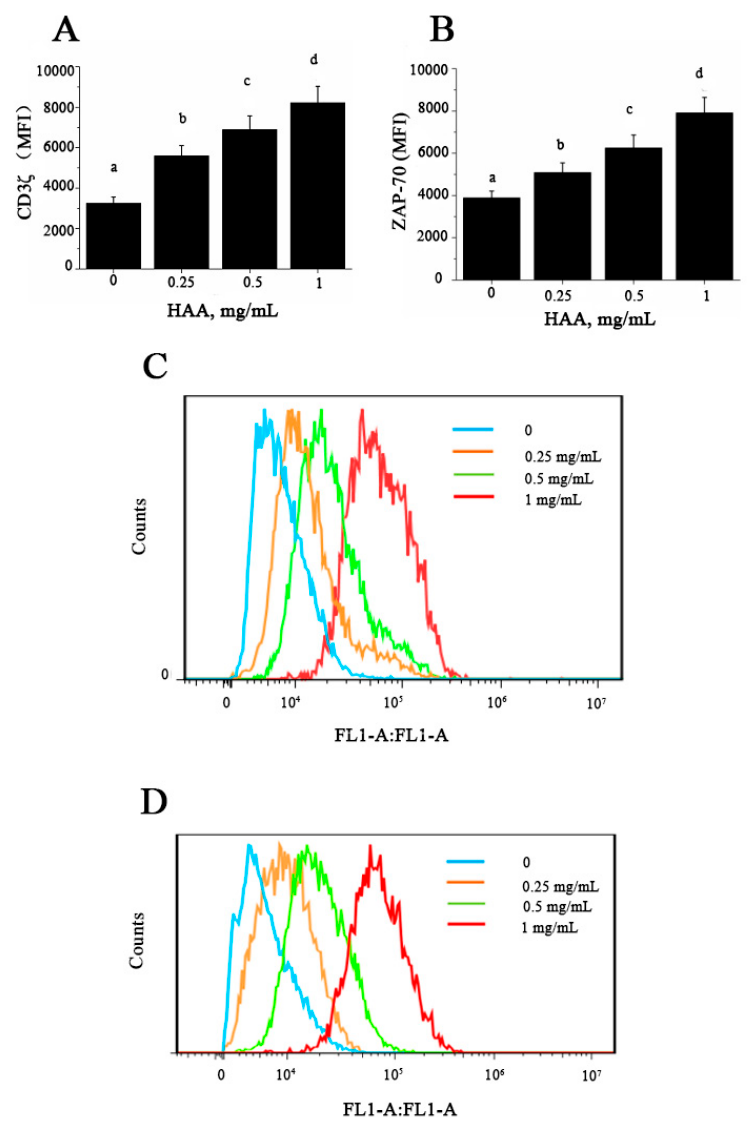
Figure 7. Effect of in vitro HAA supplementation on expression of: CD3 ζ ( A ) and ζ -chain-associated protein kinase 70 (ZAP-70) ( B ) Splenocytes were incubated in the presence of HAA at 0, 0.25, 0.5, or 1 mg/mL for 4 h and then stimulated by CD3/CD28 for 48 h. CD3 ζ and ZAP-70 expression was determined using flow cytometry; ( A , B ) Statistical summary of CD3 ζ and ZAP-70 expression presented as mean fluorescence intensity (MFI), respectively; ( C , D ) Representative histograms for CD3 ζ and ZAP-70, respectively. Values are means ± SD, n = 10. Means in a row without a common letter significantly differ as determined by one-factor ANOVA, p < 0.05.